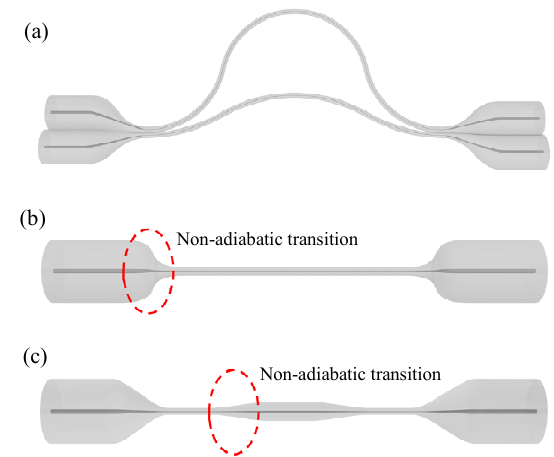
Fig. 4 Schematic of MFI structures: (a) microfiber Mach-Zehnder interferometer (MZI); (b-c) microfiber modal interferometers with non-adiabatic